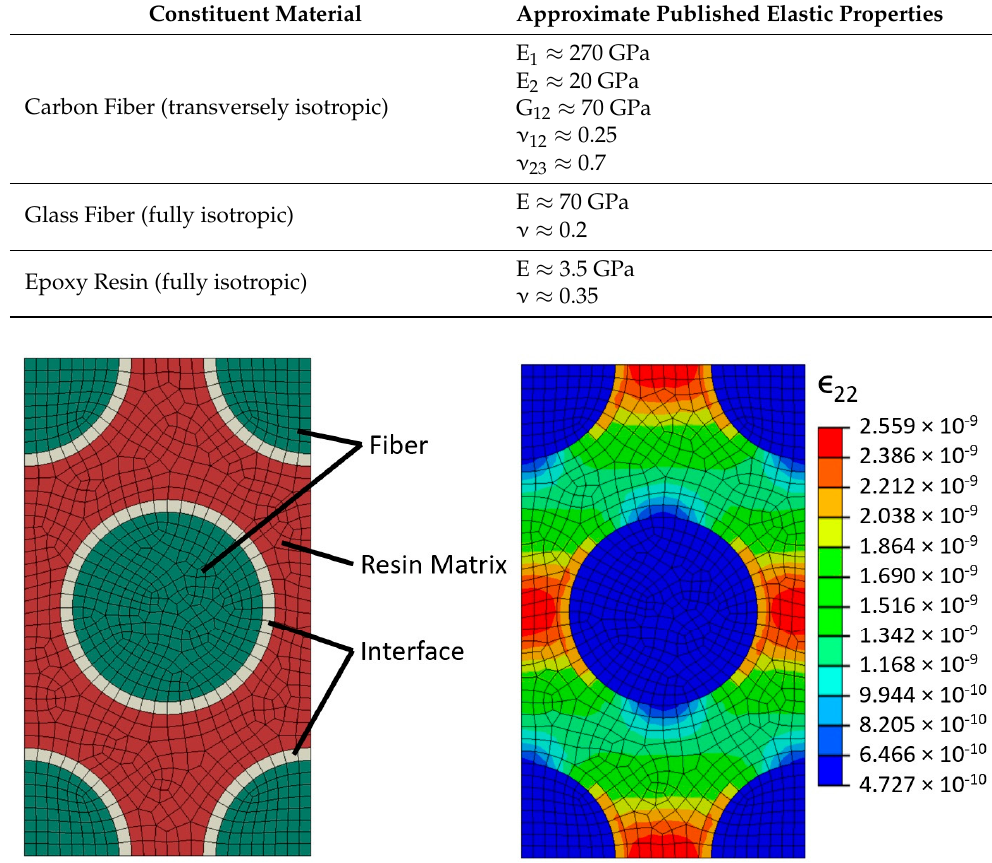
Table 2. Approximate values for elastic properties of constituent materials taken from a survey of the literature [39–41].